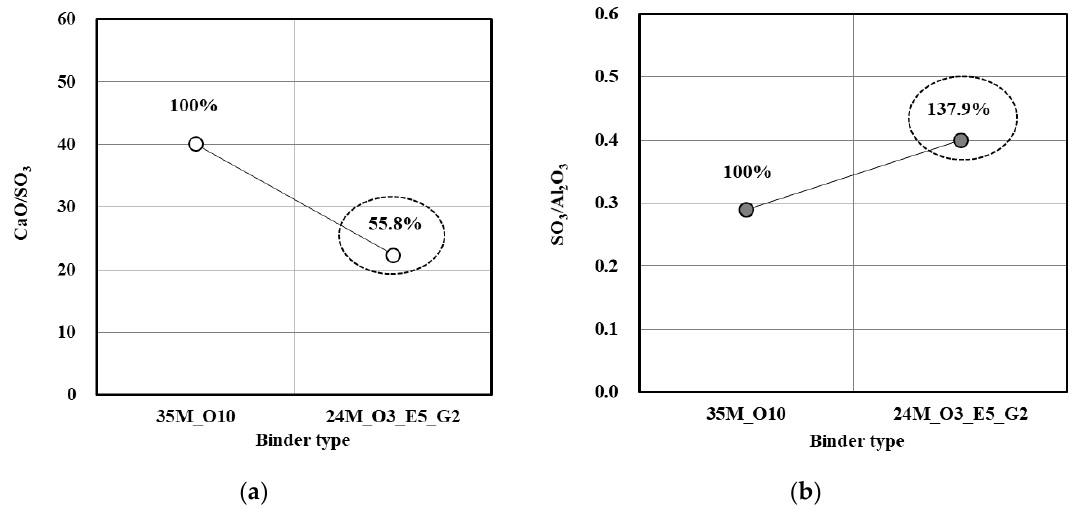
Figure 8. ( a ) CaO / SO 3 and ( b ) SO 3 / Al 2 O 3 ratios according to binder type. Figure 8. ( a ) CaO/SO 3 and ( b ) SO 3 /Al 2 O 3 ratios according to binder type.